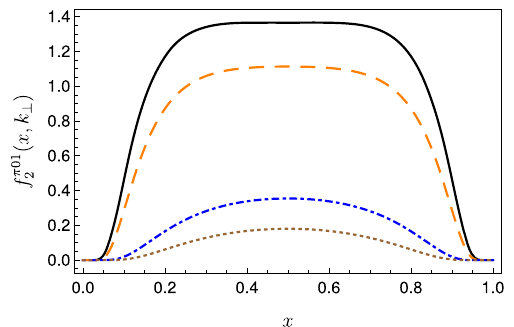
Fig. 3 Double PDFs of the pion evaluated within the dynamical spin effects model [44] for different values of k ⊥ . Full black line k ⊥ = 0 GeV, dashed orange line k ⊥ = 0 . 2 GeV, dot-dashed blue